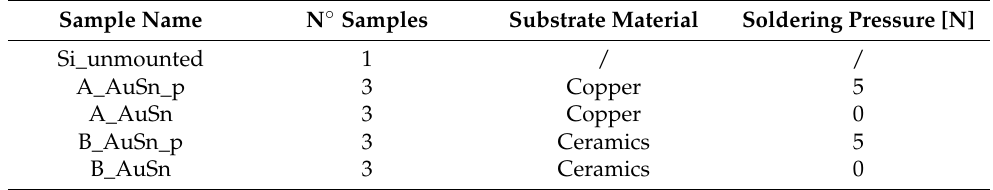
Table 1. Investigated samples: unmounted Si chips or mounted with a soldering process using an interconnection of